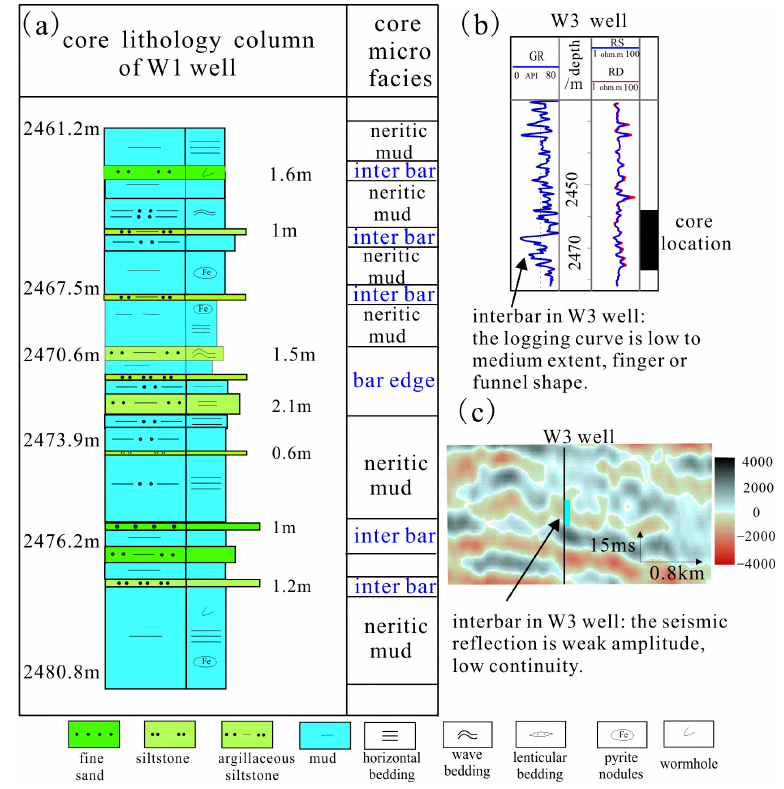
Figure 10. Core lithology column ( a ), logging motifs ( b ), and seismic reflection of interbar microfacies ( c ).